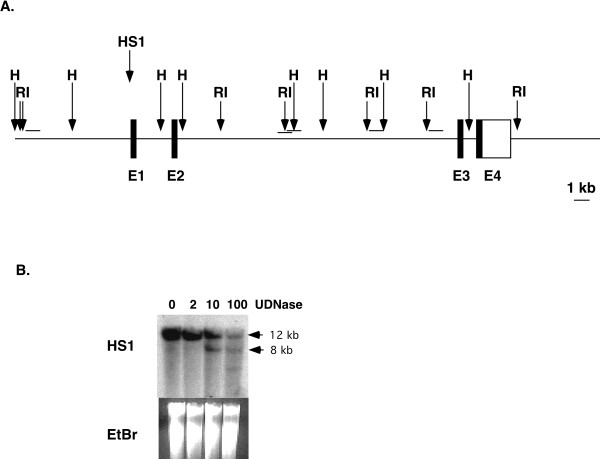
DNase I hypersensitivity studies. In (A), a schematic representation of the CCR3 gene is shown. Exons 1 through 4 (E1 – E4) are depicted as boxes; open box represents the open reading frame, while the closed box represents the untranslated region. The position of Hind III (H) and Eco RI (RI) restriction sites is depicted with arrows and probes used for DNase I hypersensitivity are depicted as lines above the genomic fragment. The position of hypersensitive site is depicted as HS1. In (B), Southern blot analysis for the HS site is shown. Nuclei from the primary human eosinophils were digested with indicated doses of DNase I for 5 minutes at 30°C. Following DNA purification and digestion with restriction enzymes (shown in figure is Eco RI), DNA was electrophoresed on an agarose gel and transferred to nylon membranes. Following hybridization with genomic probes, membranes were exposed to film. Size markers are shown on the right. Ethidium bromide staining of the gel is also shown.